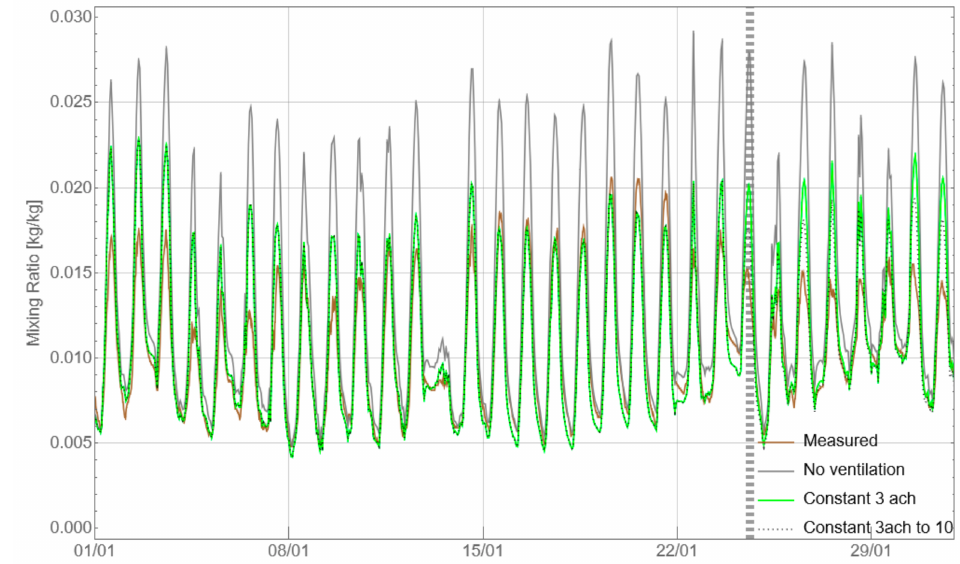
Figure 11. Results from the WUFI ® 2D simulation—mixing ratio of the roof cavity air simulated for no ventilation and ventilation boosting from 3 ach to 10 ach (daytime, 3 ach otherwise) after the fan is installed. The graph also shows the constant ventilation rate of 3 ach only, illustrating the difference to the